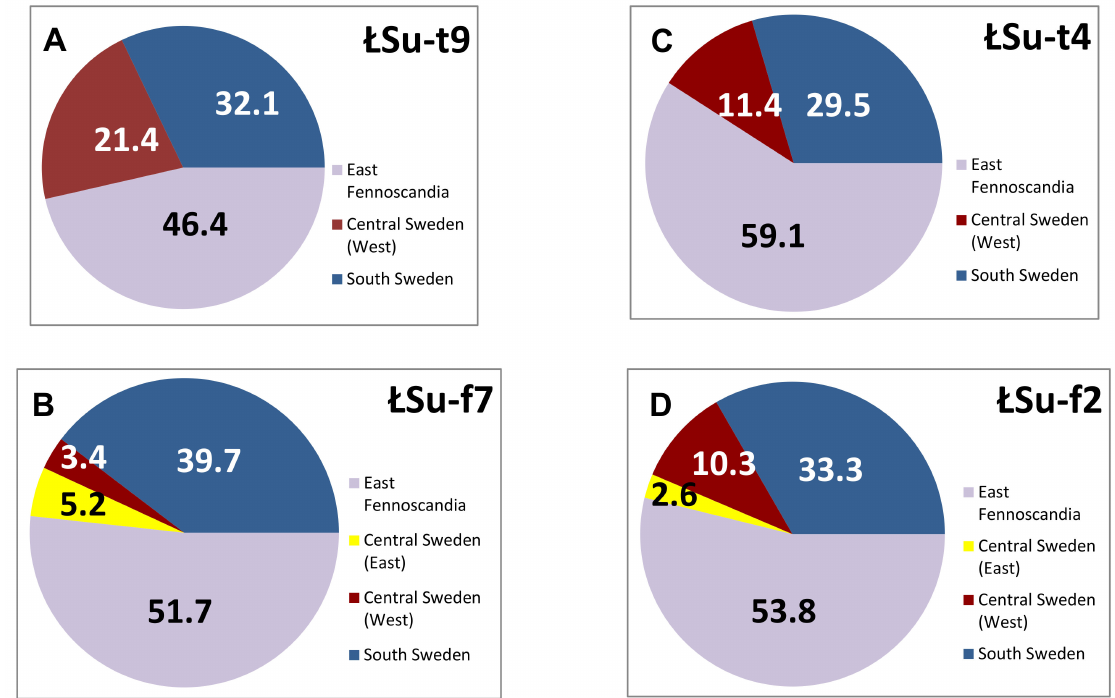
Figure 7. Erratics provenance of two lower ( D , C ) and two upper ( B , A ) units. The provinces are based on Lang et al. [30] and references therein. The numbers are shown as a